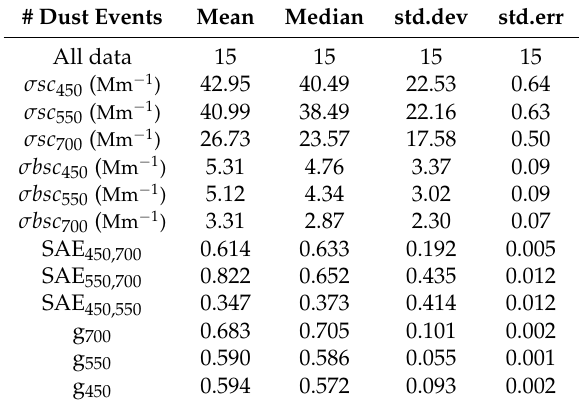
Table 6. Statistics ( σ sc , σ bsc , SAE, g), at LMT Observatory, all selected dust events. # Dust Events